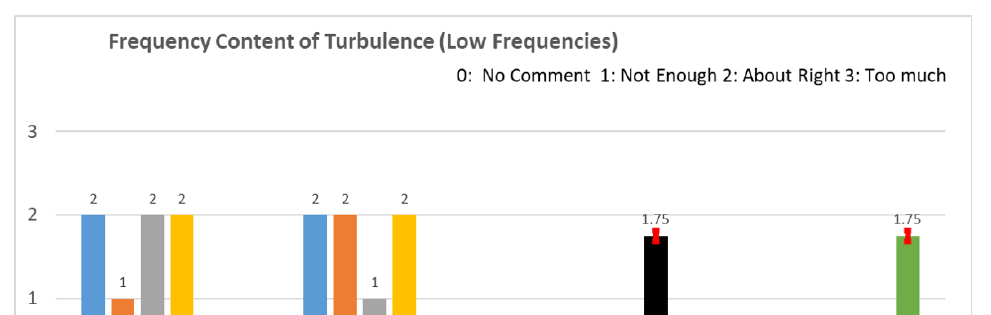
Figure A8. Patchy characteristics.